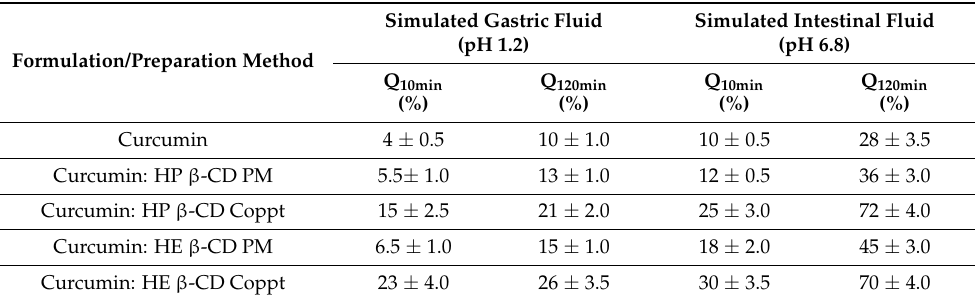
Formulation/Preparation